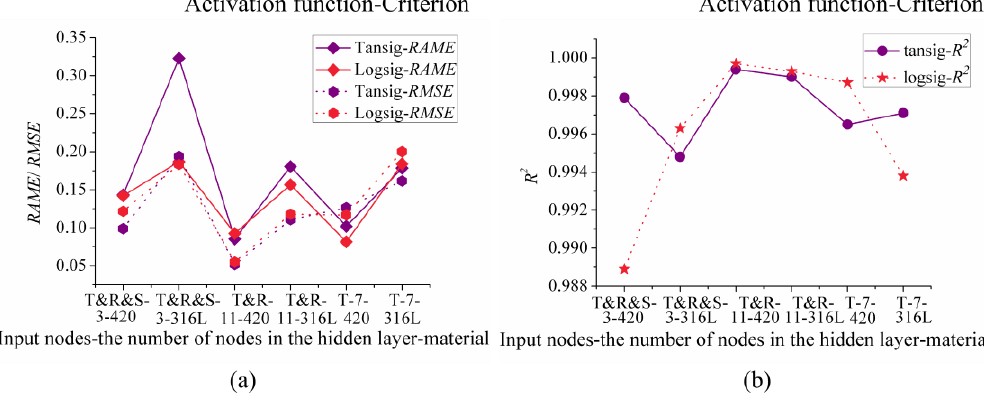
Figure 7. Criteria for models with different activation functions: ( a ) RAME and RMSE and ( b ) R 2 .